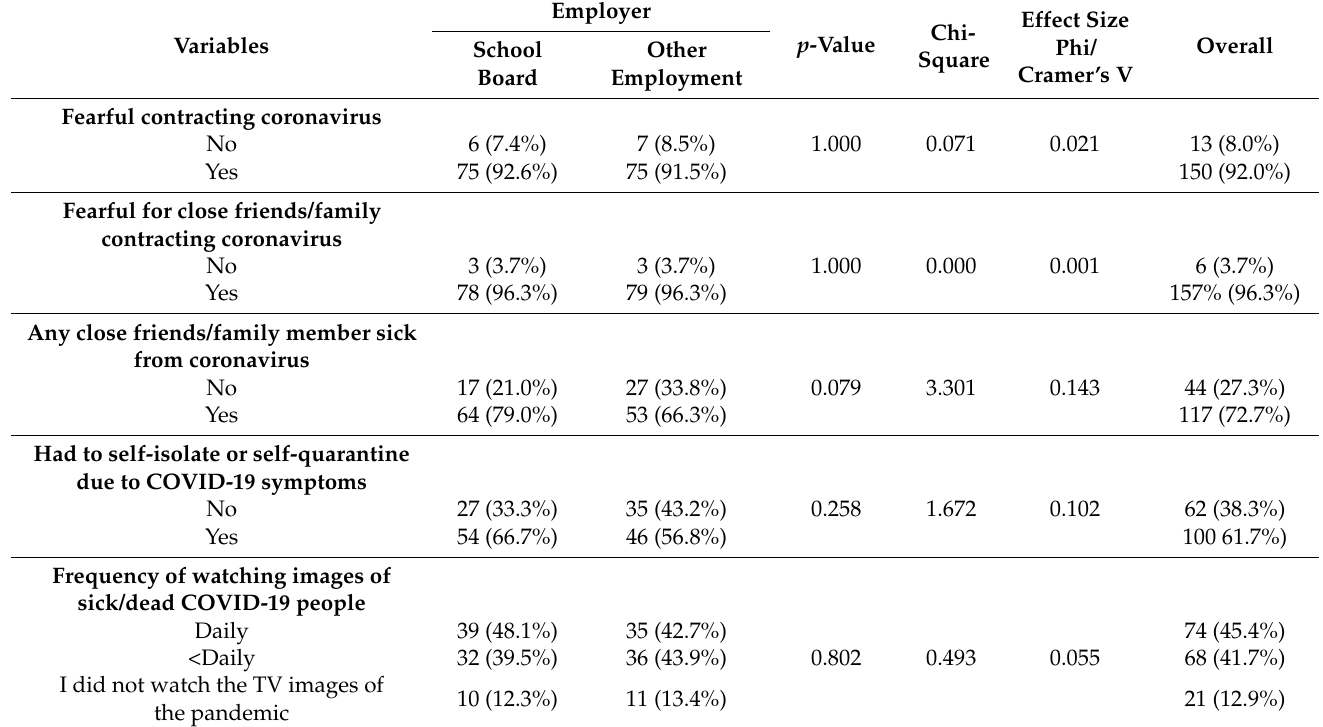
Table 3. Chi-square test of association between employer type and COVID-19 related